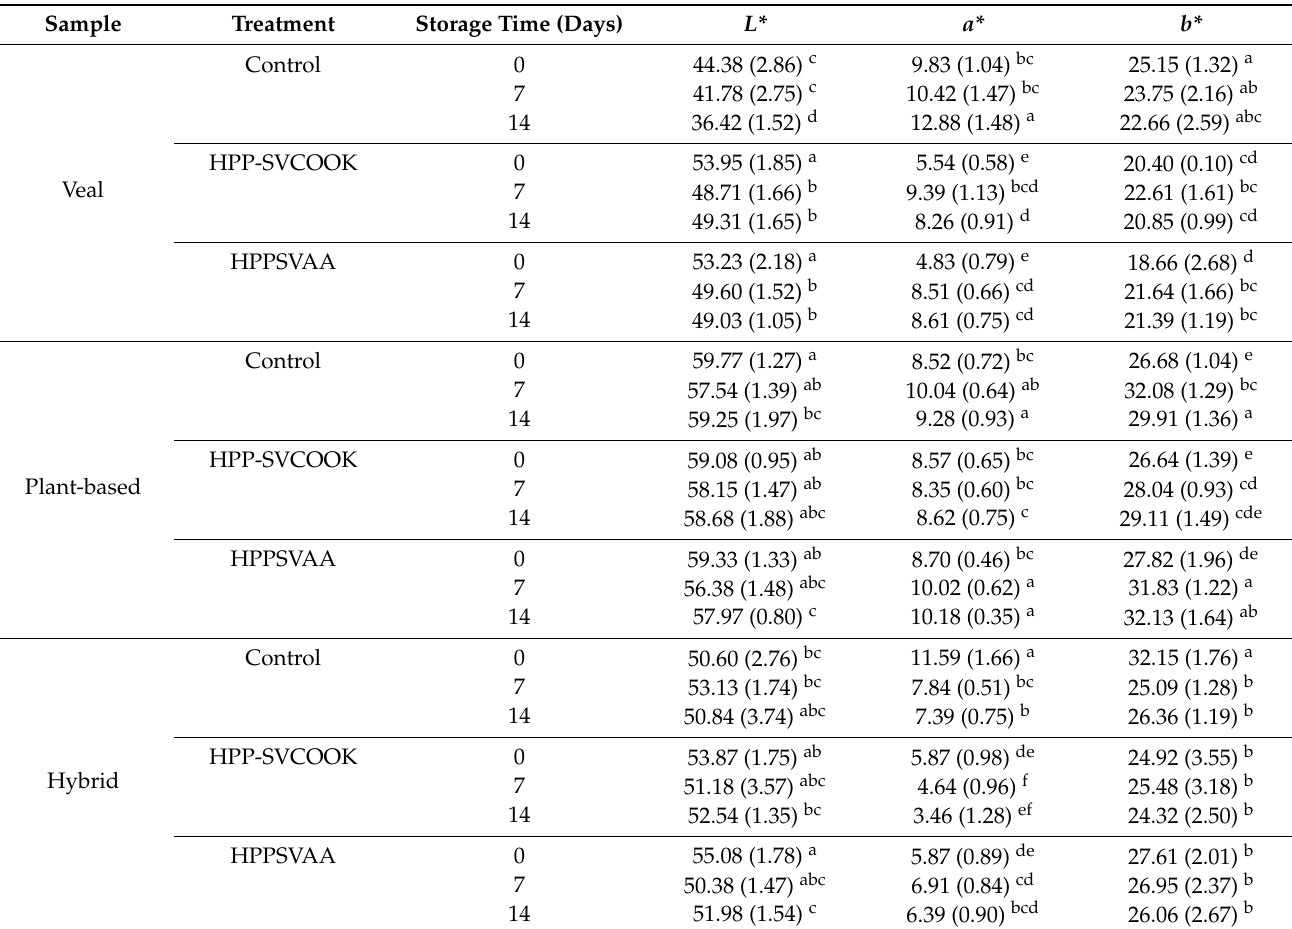
Table 4. Effect of treatment and storage time on the color parameters of veal, plant-based, and hybrid